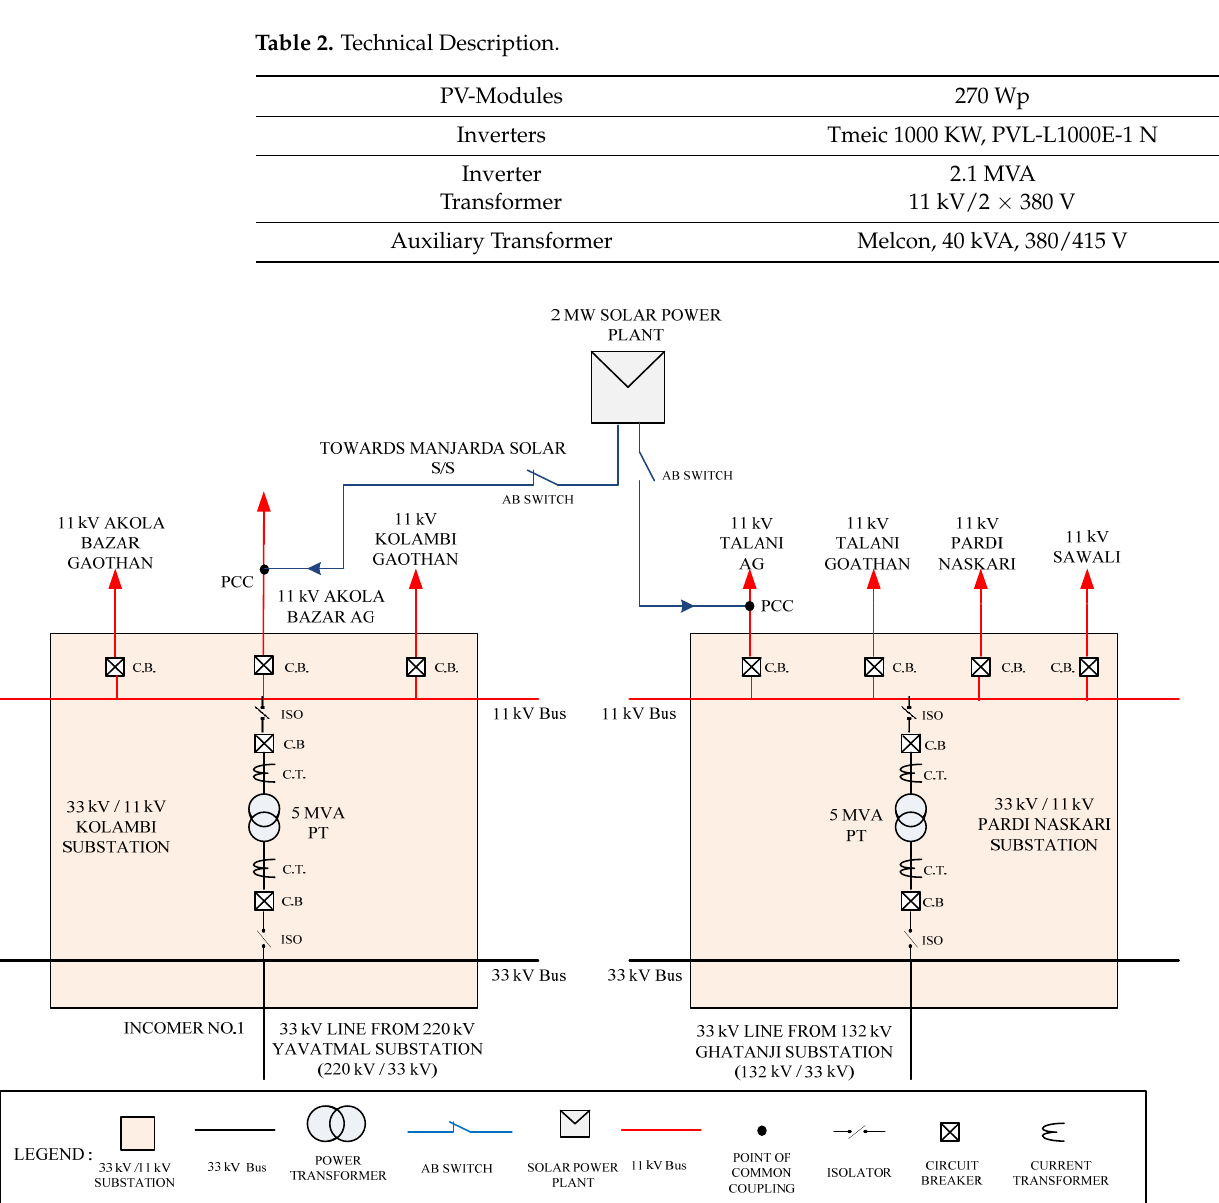
Table 2. Technical Description.